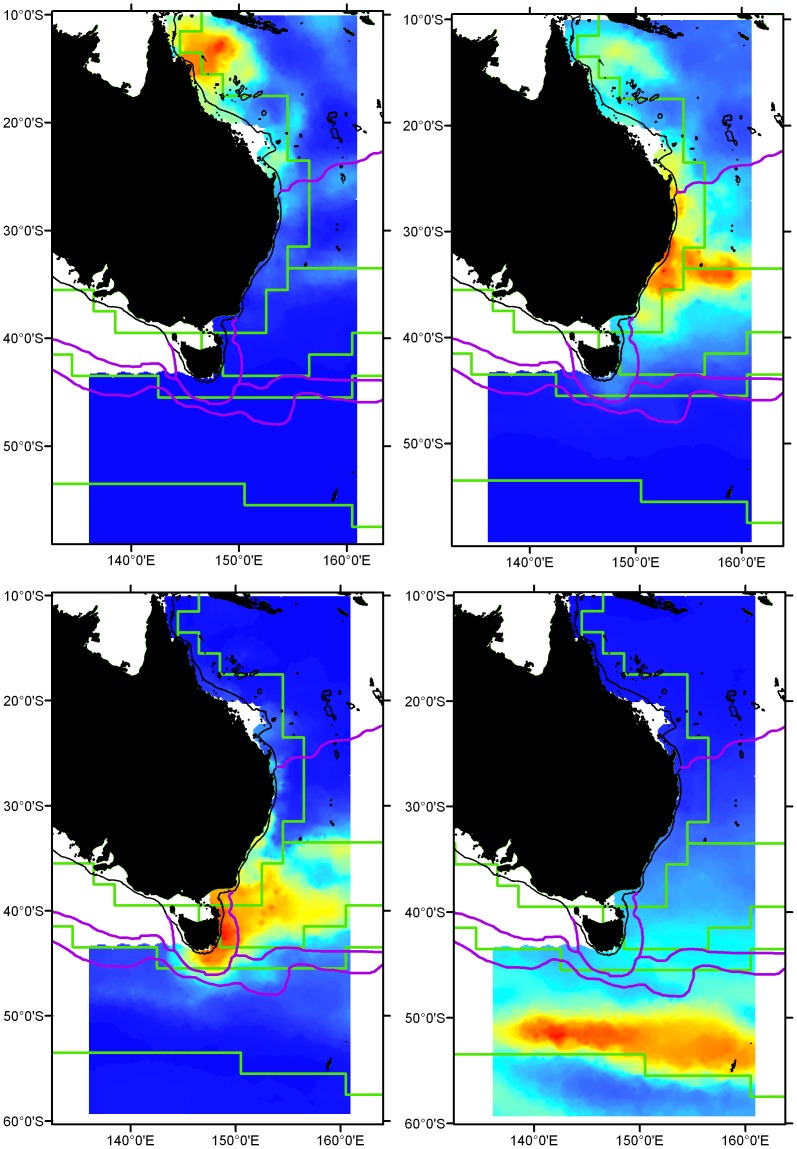
Visualisation of the 4-group hypothesis of lanternfish zoogeographic regions overlaid on biogeographic regions of Longhurst [26] (Green lines) and Condie and Dunn [27] (Purple lines).The heat maps represent mean logistic scores that can be interpreted as model predictions of likelihood of occurrence from high (warm colours) to low (cool colours). Heat maps are provided for each of the 4 hypothesised regions, clockwise from top left: Coral Sea region, STLW region, Subantarctic region, STC/South Tasman region. 200 m bathymetric contour denoting the continental shelf is shown.